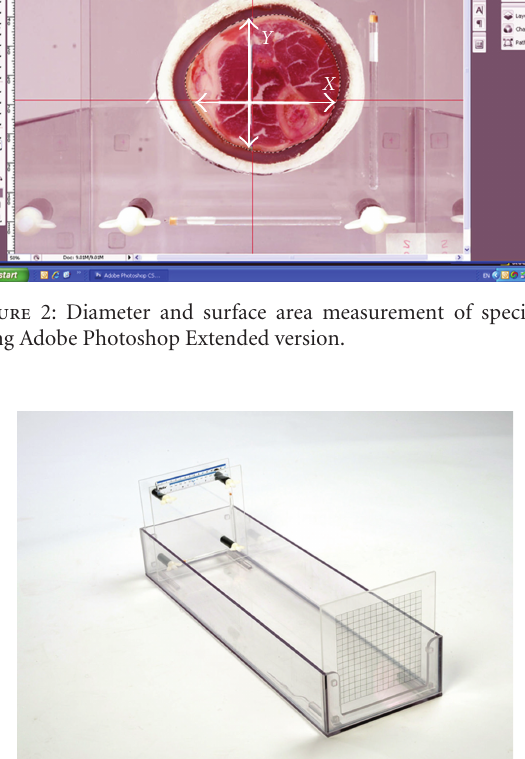
Figure 3: Grid used for adjusting of angle and distance of camera from specimens and consistent photography of all